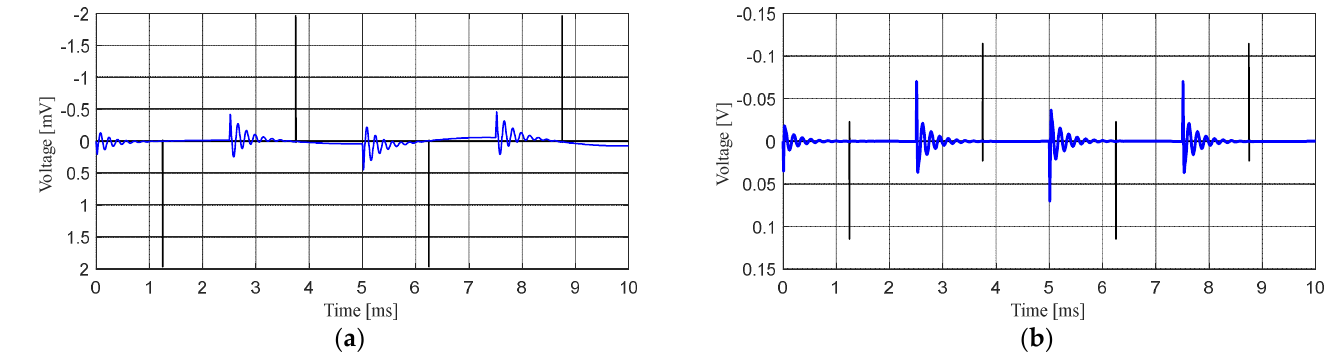
Figure 17. The voltage responses at the PD port caused by a 1 pC calibrator pulse current and the interference signal of the resonant circuit when the additional capacitor is connected and the output voltage is 100 kV: ( a ) without the band-pass filter; ( b ) with the band-pass filter recommended by the standard.